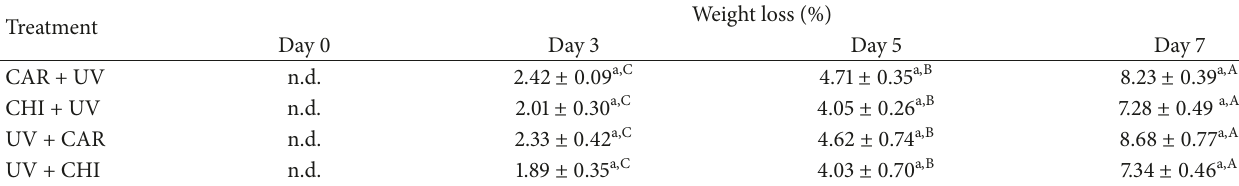
Different lowercase letter indicates significant difference at 𝑝 < 0.05 in each storage day; different uppercase letter indicates significant difference at 𝑝 < 0.05 in each treatment; n.d.: not detected; CAR + UV: carrageenan plus ultraviolet treatment; CHI + UV: chitosan plus ultraviolet treatment; UV + CAR: ultraviolet treatment plus carrageenan coating; UV + CHI: ultraviolet treatment plus chitosan